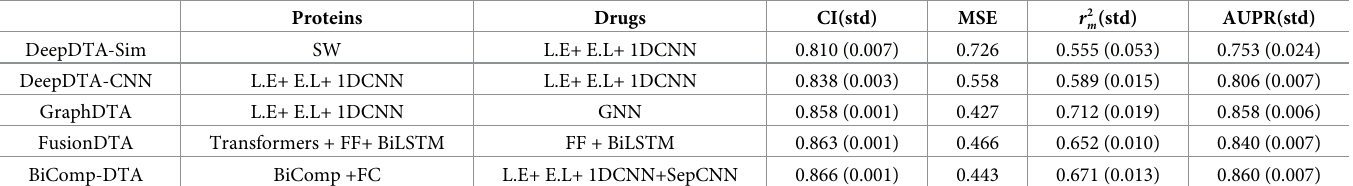
Table 3. The CI, MSE, r 2 and AUPR values for the BiComp-DTA compared to the alternative methods—BindingDB dataset. m Proteins